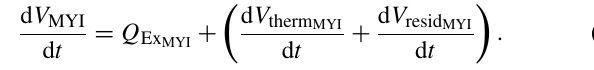
) and simultaneous Arctic MYI volume growth rates (d V MYI / d t ) MYI , and the corresponding coefficient of determination ( r 2 MYI